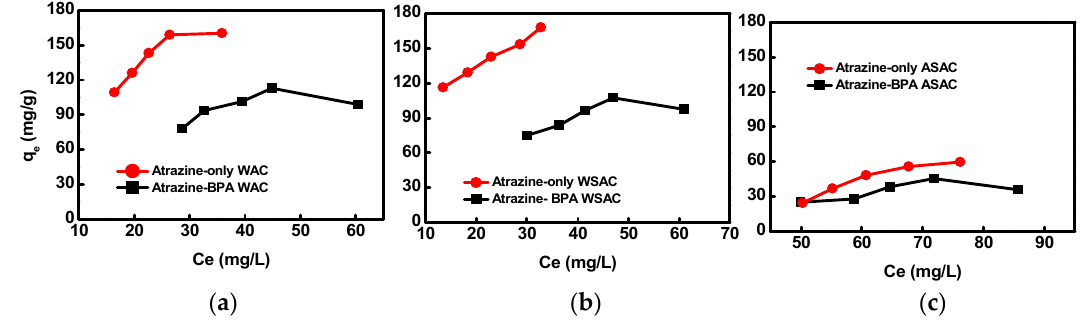
Figure 4. Effect of BPA on adsorption isotherms of atrazine onto WAC(a), WSAC(b), ASAC(c). Table 7. Effect of BPA on adsorption isotherm parameters of atrazine onto ACs.